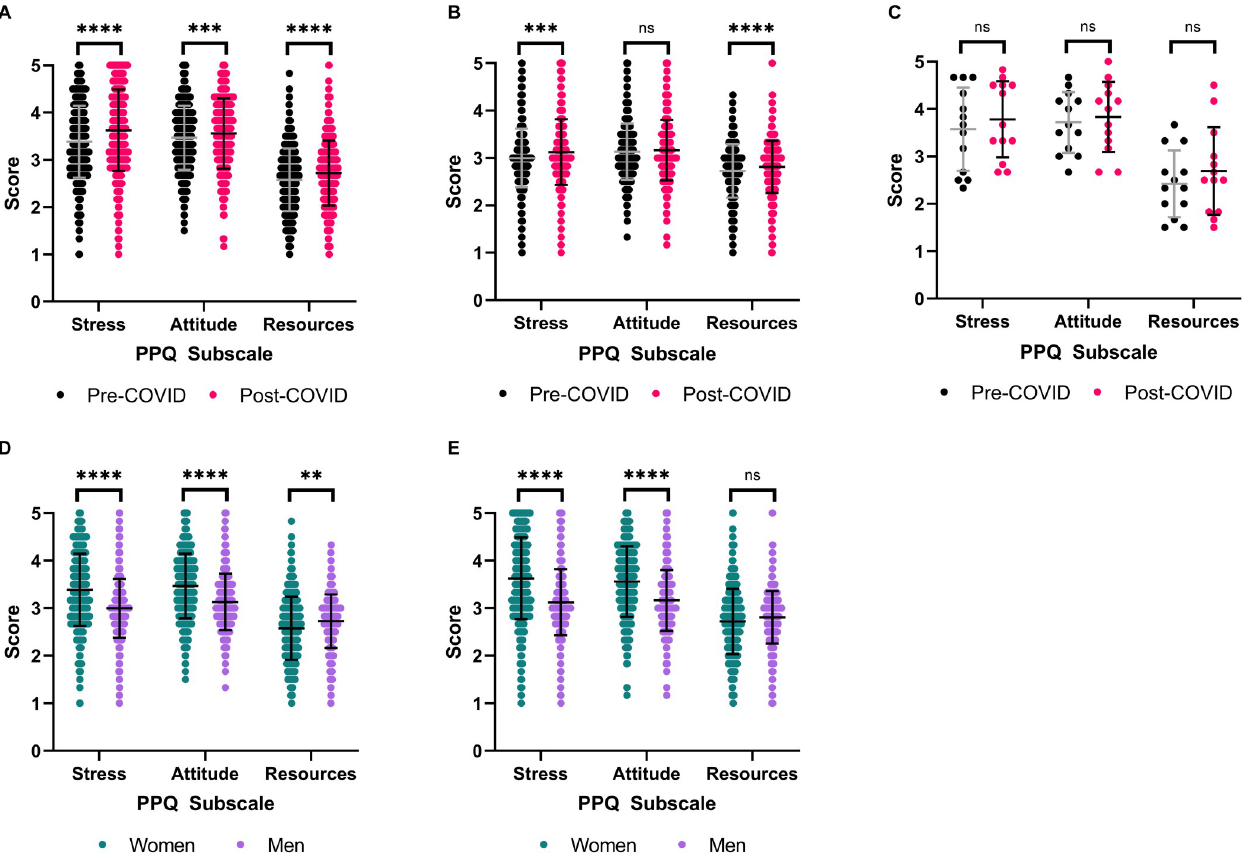
Fig 4. Differences in publication pressure questionnaire subscale scores stratified by gender. Paired (A-E) and independent (D-E) Student’s t-test with Bonferroni correction. �� P � 0.01, ��� P � 0.001, ���� P � 0.0001. (A) Respondent Scores from Women. N = 484. (B) Respondent Scores from Men. N = 462. (C) Respondent Scores from non-binary or genderfluid people. N = 13. (D). Pre-COVID subscale score comparison between women and men. N = 462–484. (E) Post-COVID subscale score comparison between women and men. N = 462–484.